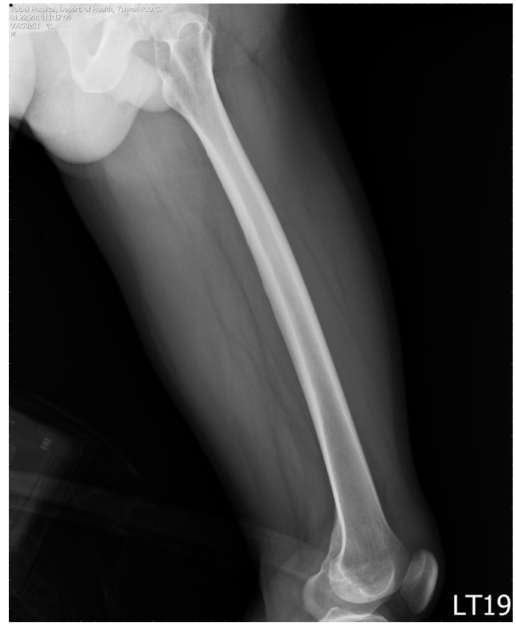
Figure 2. An example of the included